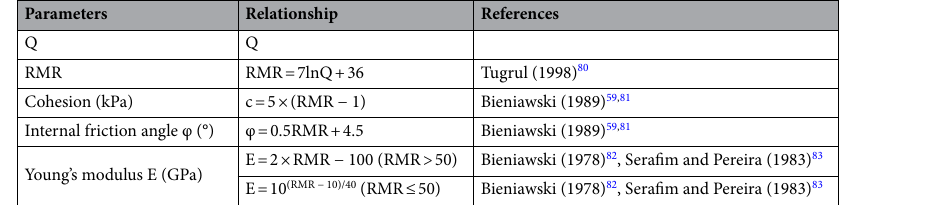
Table 7. Empirical equations relating Q with rock mass